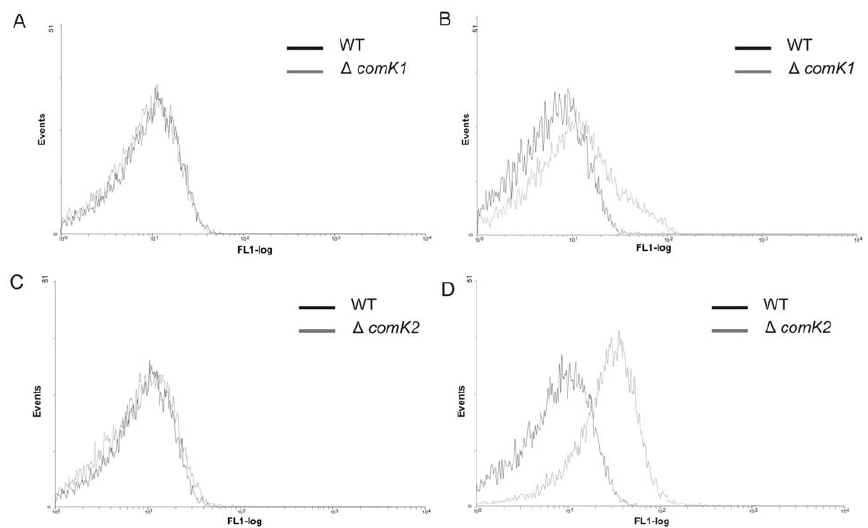
Figure 2. Flow cytometric analysis of PcomK1-gfp (A,C) and PcomK2-gfp (B,D) in liquid minimal medium. Promoter fusions in wild type (black) and in comK1 (A,B) or comK2 (C,D) mutant (gray). Analyses were performed as described in Experimental procedures. The numbers of cells are indicated on the y axis, and their relative fluorescence levels are indicated on the x axis on a logarithmic scale. For each experiment at least 20,000 cells were analysed. The graphs are the representative of at least three independent experiments. doi:10.1371/journal.pone.0021859.g002 IPTG. In comK1 mutant strain a lower P comGA - gfp expression was detected in the comK Bsu overexpression samples (Fig 4C and Table 2). This indicates in agreement with the overexpression constructs that ComK1 positively effects the expression of comG operon when comK Bsu is overexpressed in B. cereus .